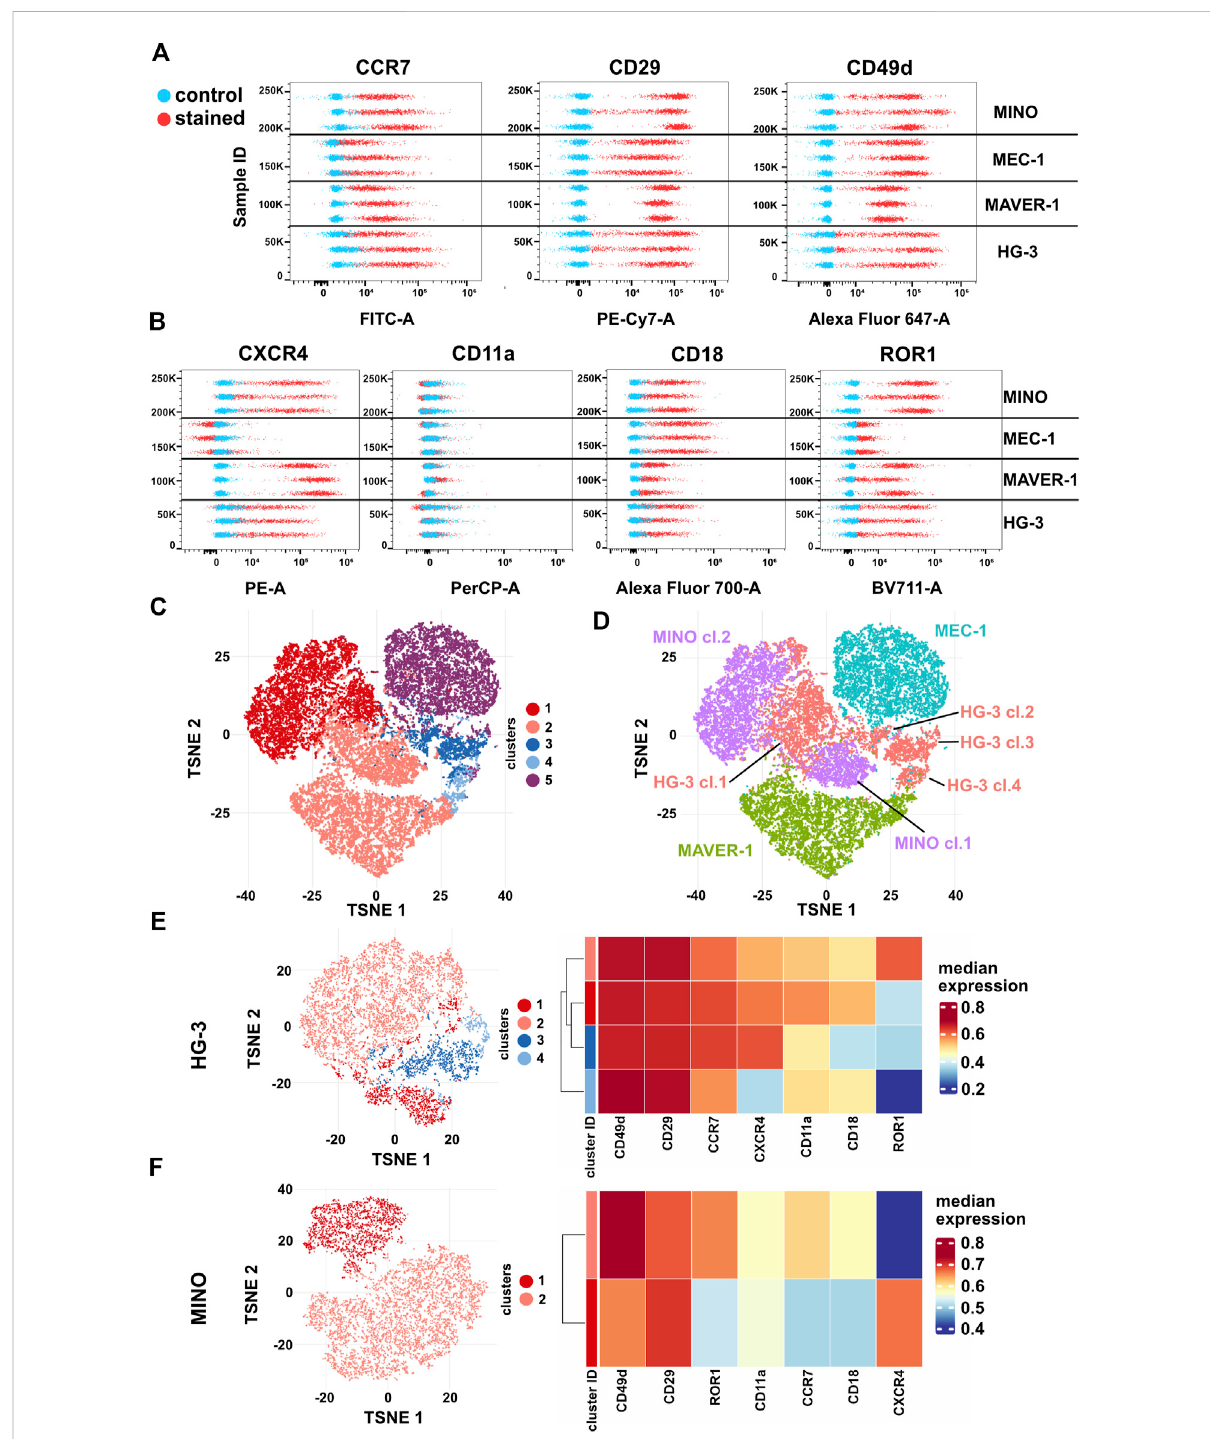
FIGURE 6 Expression of surface markers (A) CCR7 (CCL19 receptor), CD29 and CD49d (VLA4 integrin subunits), (B) ROR1 and CXCR4 (CXCL12 receptor), and CD11a and CD18 (LFA1 integrin subunits) in HG-3, MAVER-1, MEC-1, and MINO cells. Stained (red) and unstained control (blue) samples are shown as dot plots of fl uorescence intensity. Three replicate measurements for each cell line are shown; for quanti fi cation, see Supplementary Figure S5. (C) Representative tSNE visualization of metaclusters automatically generated by FlowSOM of HG-3, MAVER-1, MEC-1, and MINO cells from one replicate shown in (A – B) . (D) tSNE visualization of cell line distribution. (E) Left: tSNE of the HG-3 cell line upon subtraction from the datasetshownin5C.Right:heatmapresumingexpressionofindividualmarkersinsubclustersoftheHG-3cellline. (F) Left:tSNEoftheMINOcellline upon subtraction from the dataset shown in 5C. Right: heatmap resuming expression of individual markers in subclusters of the MINO cell